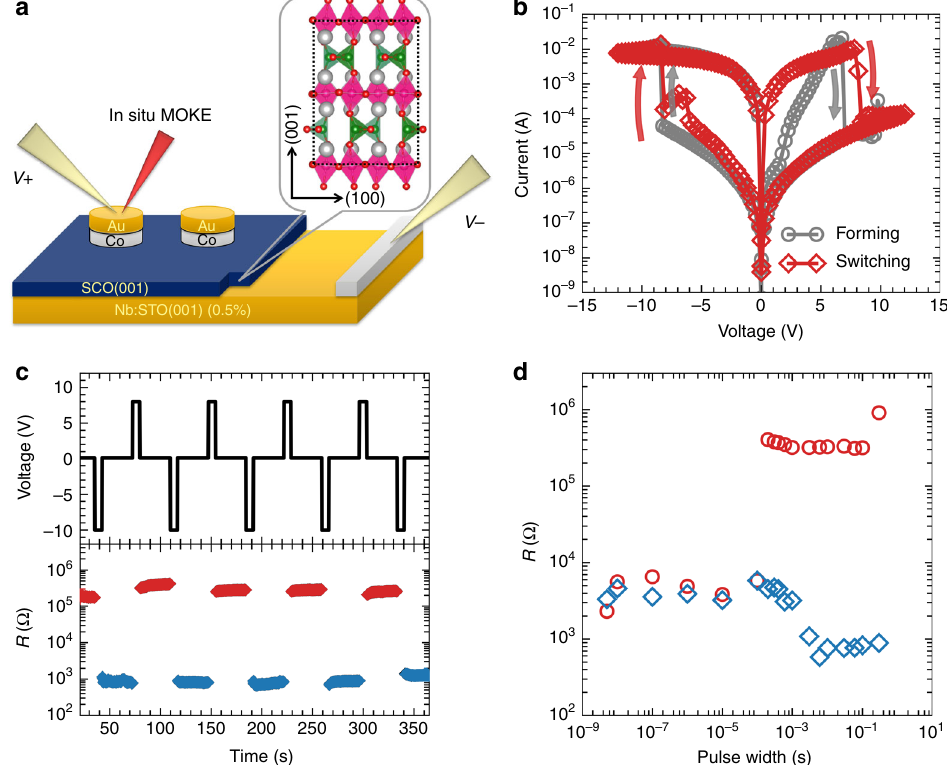
Fig. 1 Device con fi guration and resistance switch in Co/SrCoO 2.5 . a Schematic diagram of the device con fi guration with the Co/SrCoO 2.5 heterostructure for the in situ resistance switch and MOKE measurements. The electrodes are fabricated into round shape with diameter from 20 to 200 μ m. The inset illustrates the crystalline model of SrCoO 2.5 , where the silver and red balls represent the Sr and O atoms, respectively. The Co – O tetrahedral and octahedral ligands are labelled by green and pink polyhedra, respectively. b I – V characteristic curves of the device showing bipolar resistance switch behavior. c Memory repetition action based on the bipolar resistance switch. The upper panel shows the pulse sequence, while the lower panel shows the corresponding resistance during the reading. The red and navy blue dots represent the readout of the high-resistance states and low-resistance states, respectively. The reading voltage was fi xed at +0.1 V. d Resistance switching dynamics with variable pulse durations, where circles and diamonds demonstrate the resistance after positive and negative pulses,